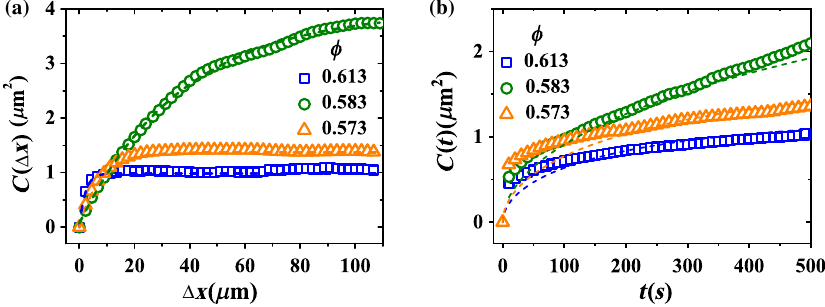
FIG. 7. (a) Spatial correlation function of the height difference fitted with Eq. (B2) (dashed curves). The fitted ξ ¼ 2 . 47 , 37.6, and 7 . 5 μ m at ϕ ¼ 0 . 613 , 0.583, and 0.573, respectively. (b) Time correlation function of the height difference fitted with Eq. (B3) (dashed curves). The fitted τ ¼ 402 , 2267, and 657 s at ϕ ¼ 0 . 613 , 0.583, and 0.573, respectively.